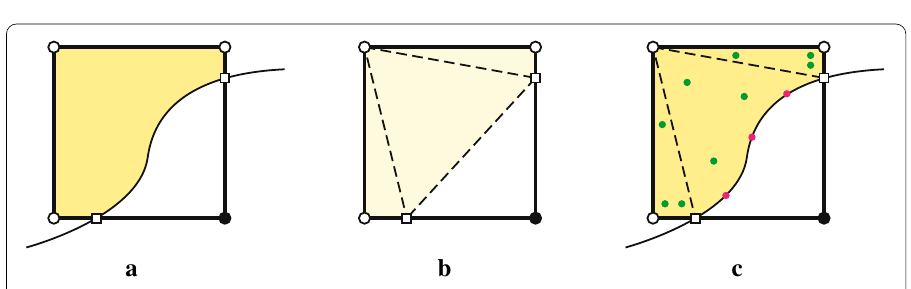
Fig. 3 Surface and volume discretization using the Marching Cubes algorithm and cgFEM. a Inside-outside test of nodes using intersections data. b Marching Cubes topology. c Volume (green) and surface (red) quadratures considering CAD